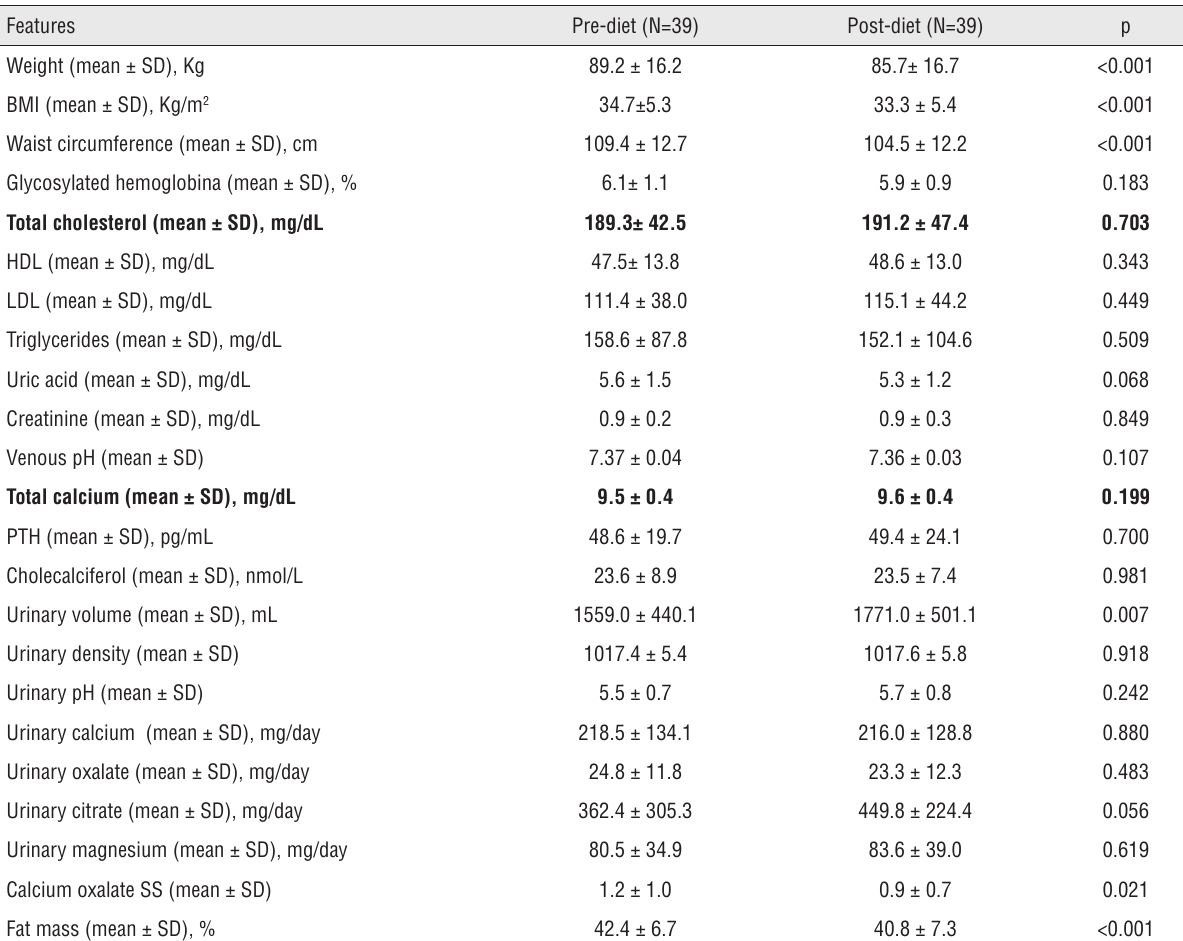
Table 2 - Metabolic features of pre vs. post-low calorie diet.